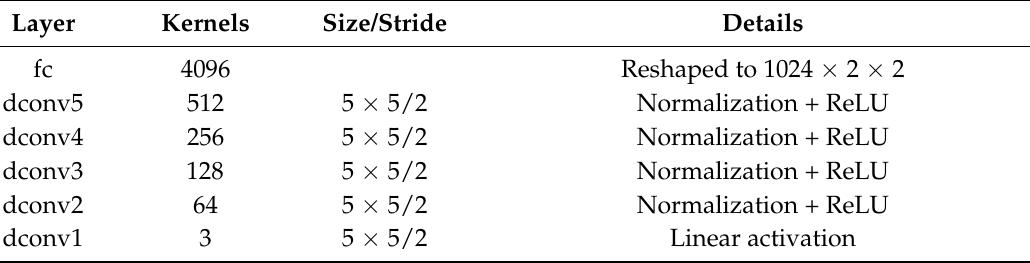
Table 2. A tabular representation of the decoder/generator layers’ specifications.